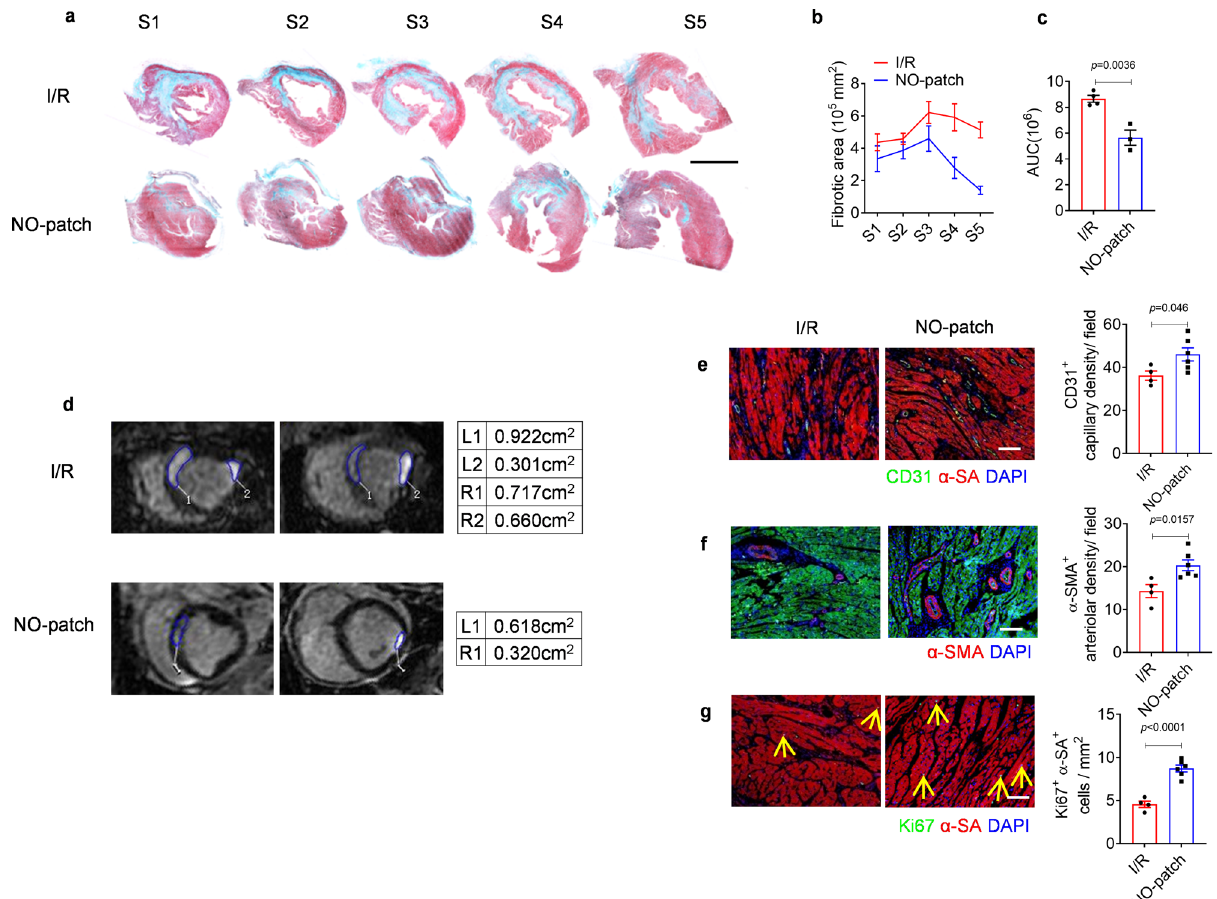
Fig. 9 Local NO delivery by nitrate-functionalized cardiac patches reduces infarcted size and alleviates adverse ventricular remodeling in pigs. a – c Masson trichrome staining was performed in sections acquired from fi ve planes from cardiac apex to base (S1-S5, scale bar, 10 mm), and fi brotic area